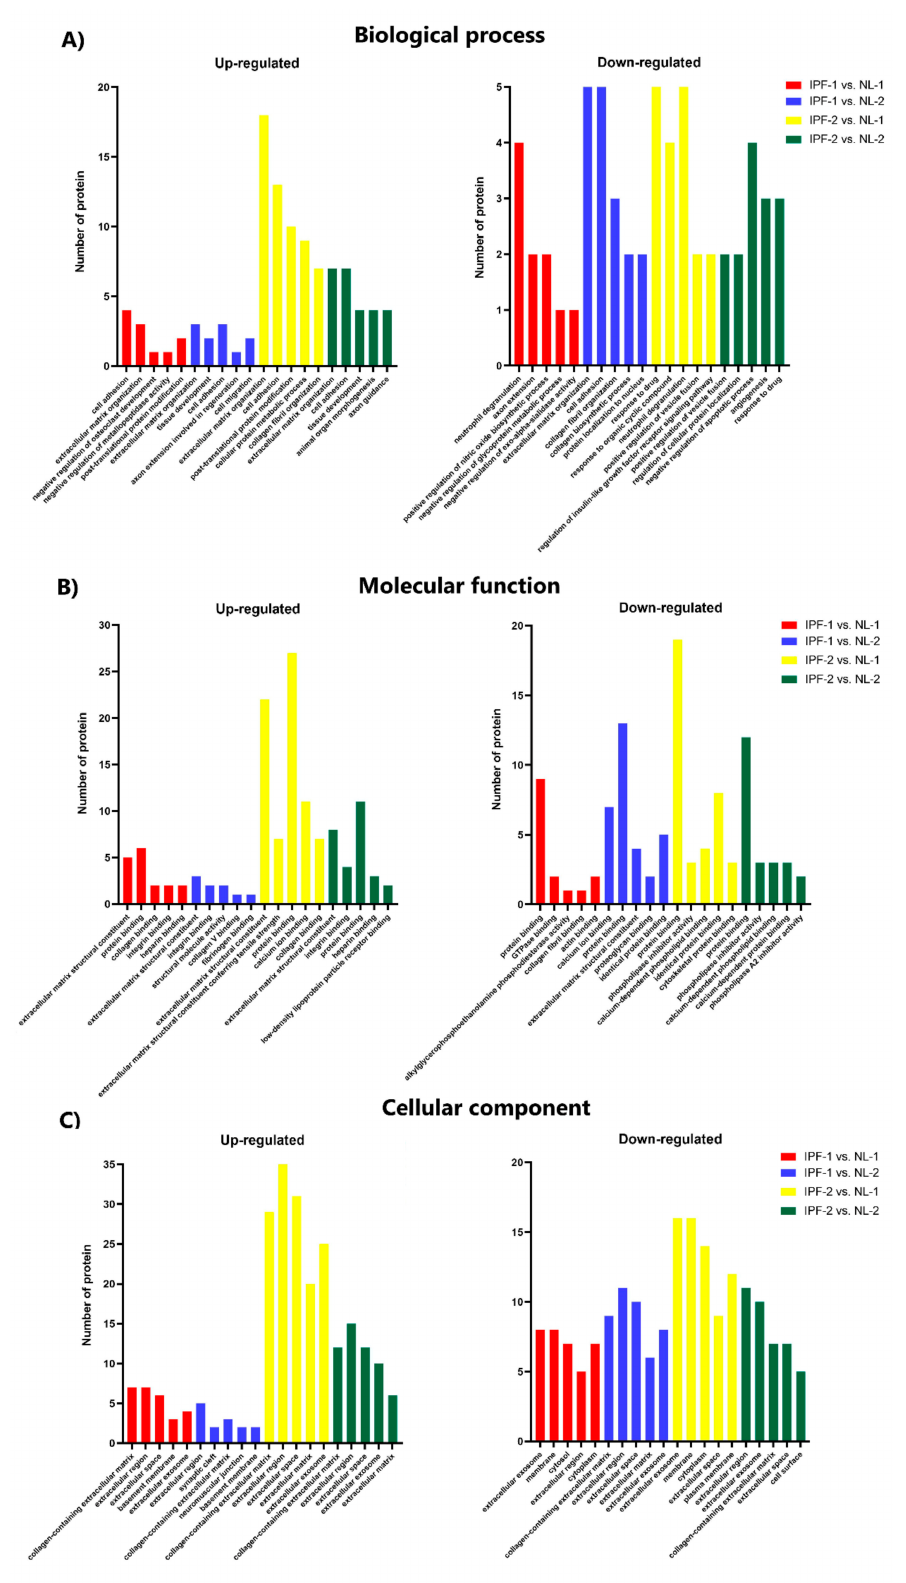
Figure 4. GO analysis showing differentially expressed proteins in five main processes. ( A ) Up- and down-regulated proteins in biological processes. ( B ) Up- and down-regulated proteins in molecular functions. ( C ) Up- and down-regulated proteins in the major cellular components. IPF, idiopathic pulmonary fibrosis; NL, normal